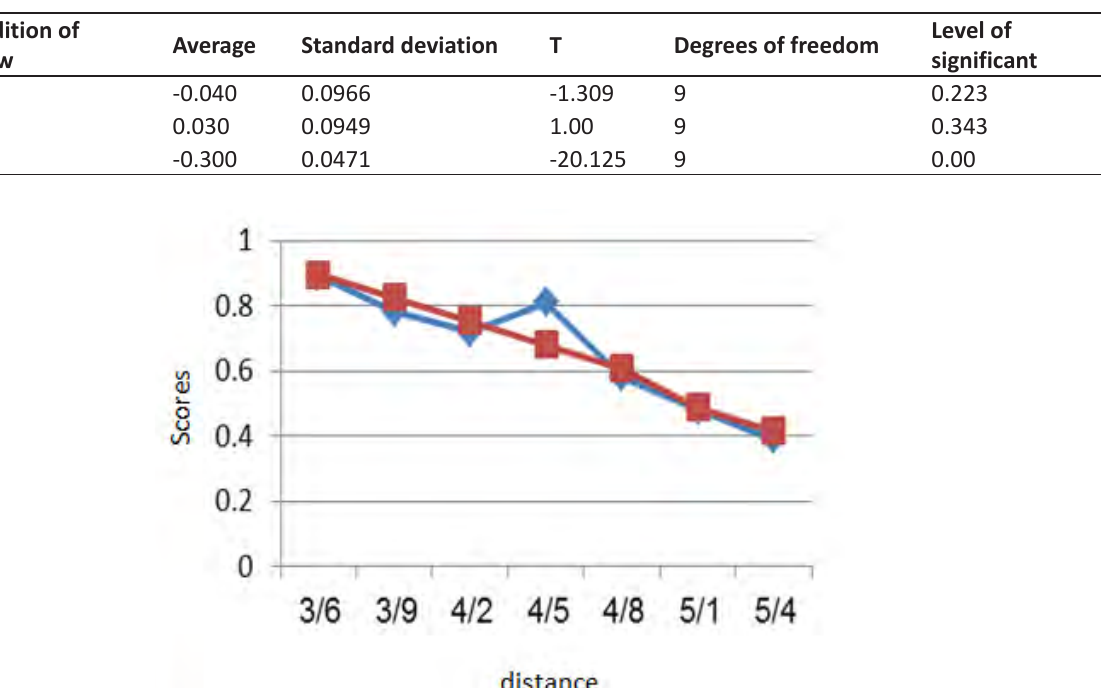
Table of paired t-test comparison of the performance of group’s free throw in different conditions of distance and width of target